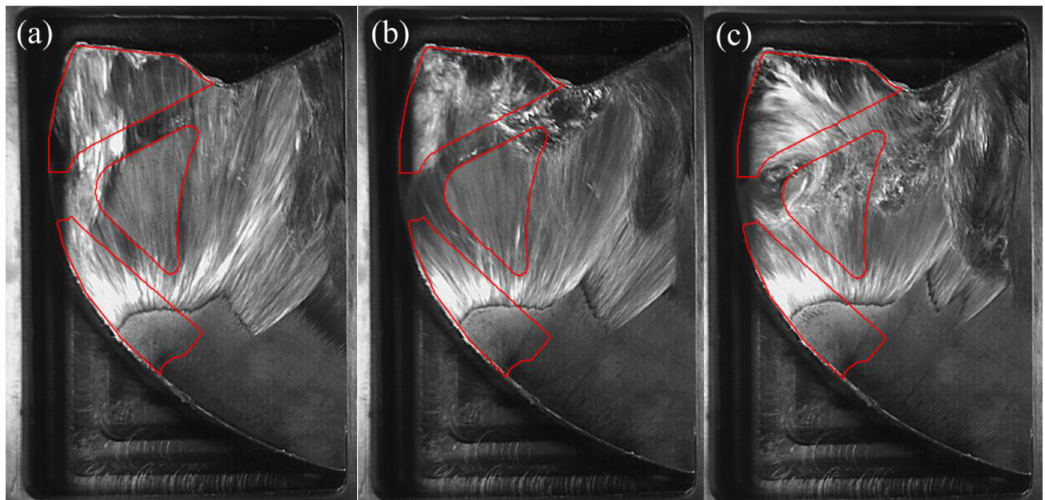
Figure 9. Flow pattern under the fast shot velocity of 2.34 m/s in the left window. ( a – c ) are arranged according to the order of